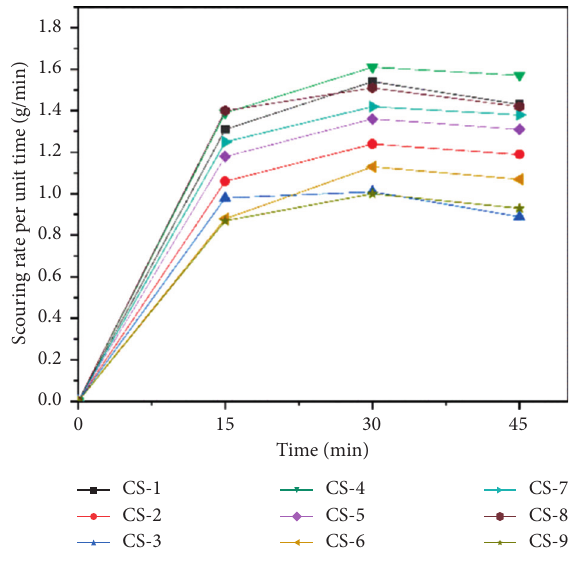
Figure 8: Scour rate over time.